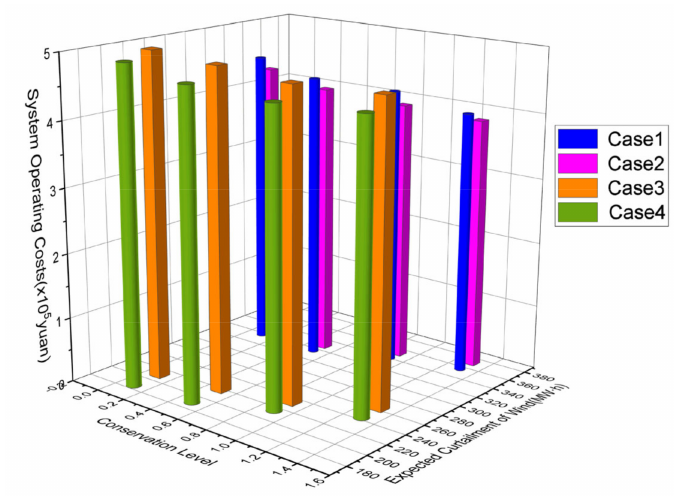
Figure 15. Results of congested wind power consumption under different conservative